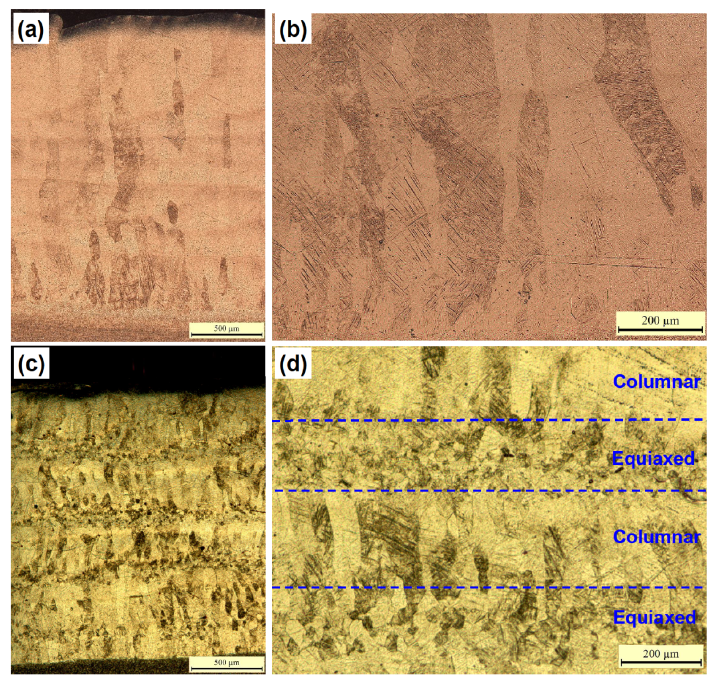
Figure 5. OM images showing the typical ( a , b ) macrostructure and grain morphology of SLM sample; ( c , d ) macrostructure and grain morphology of UIT assisted SLM sample, all samples’ hatch spacing is 0.6 mm.